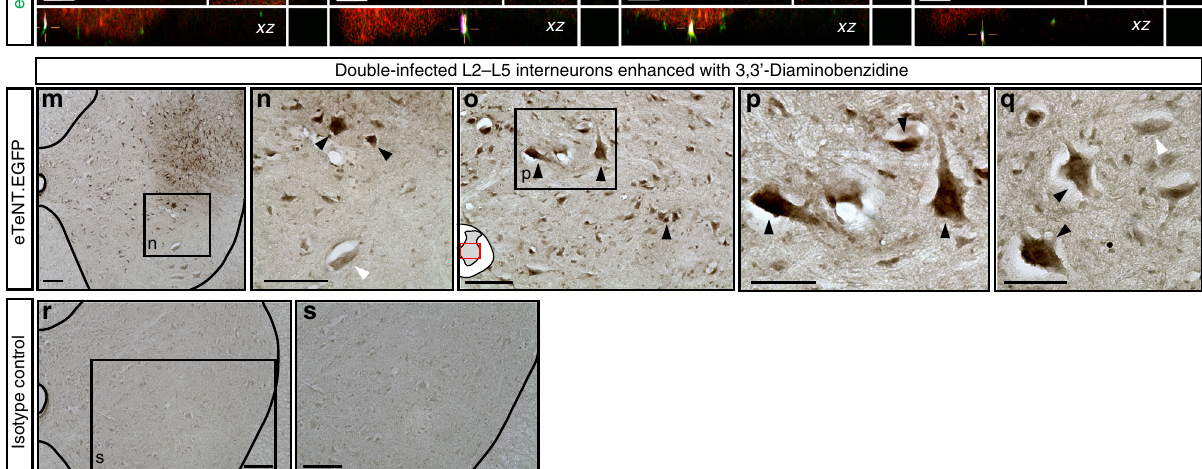
Fig. 7 Immunohistochemical detection of eTeNT.EGFP in the double-infected L2 – L5 interneurons. a – d Volumetric three-dimensional renderings show eTeNT.EGFP + terminals closely apposed to somata and primary dendrites of neurons in the intermediate gray matter (#,* indicate same neuron rotated, x – y – z axes shown in gray/magenta/blue). e Isotype control showed little to no signal (nonimmune rabbit sera at 5 mg/ml, 1:5000 dilution). f – h Volume rendered images show eTeNT.EGFP+ terminals surrounding motor neurons marked by vesicular acetylcholine transferase (VAChT, magenta) in the caudal lumbar segments. Cross-sections throughout the z -stack con fi rm colocalization of VAChT with eTeNT.EGFP in the x – z and y – z planes ( i – l , white signal in crosshairs; cross-sections throughout motor neuron shown in ( f ); a – f scale = 10 µ m). Ampli fi cation of eTeNT.EGFP signal with 3,3 ′ -Diaminobenzidine (DAB) revealed double-infected neurons within the intermediate gray matter of the L2 spinal segment ( m – q dark arrowheads = eTeNT.EGFP-positive neurons; white arrowheads = eTeNT.EGFP-negative neurons). r , s Isotype controls revealed no DAB-enhanced eTeNT.EGFP signal. m – o , r , s scale = 100 µ m; p , q scale = 50 µ